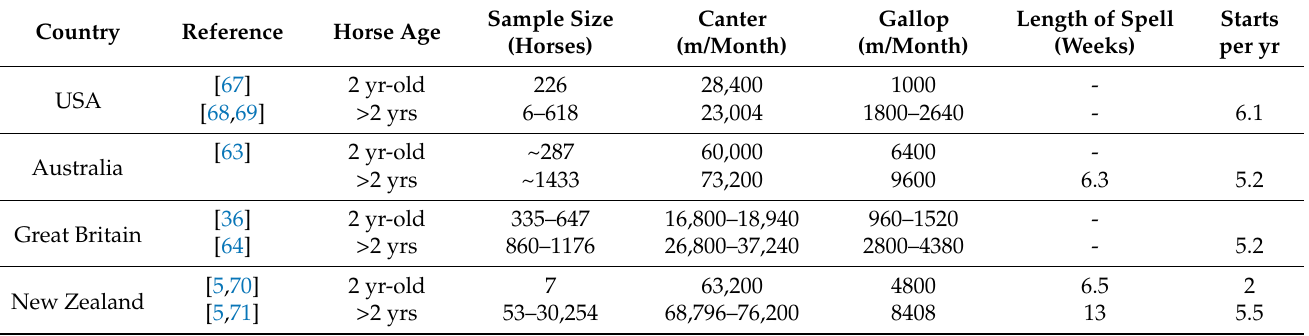
Table 3. Reported training and racing volumes per month for horses from major racing